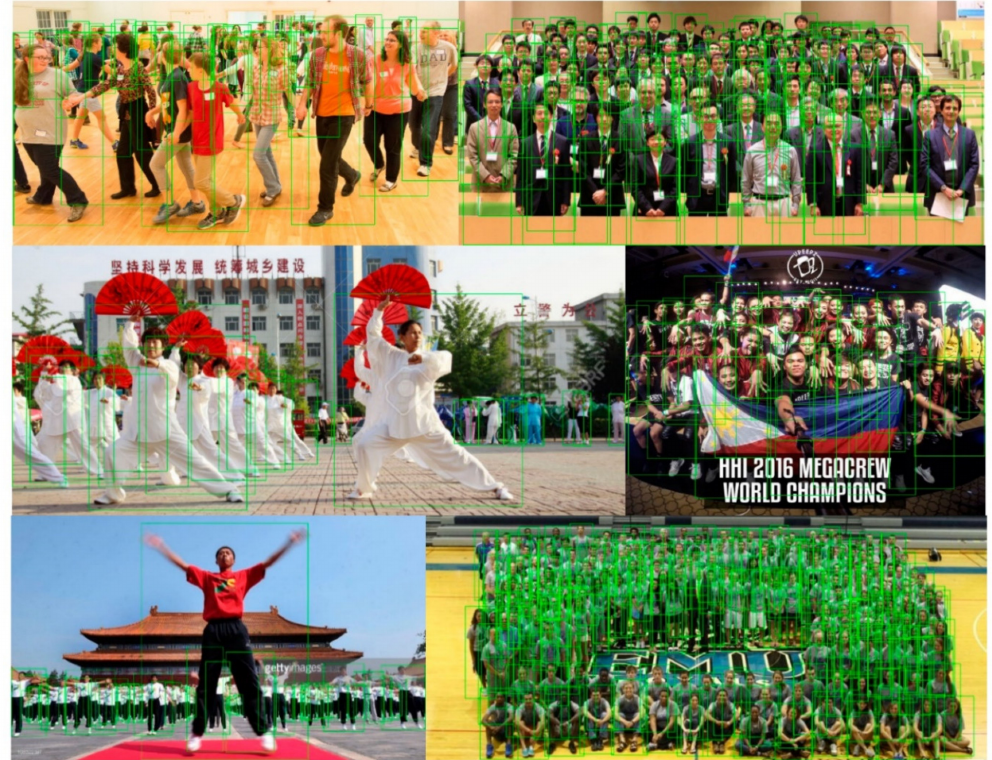
Figure 5. Detection results with our method. Although there are heavy occlusions in these images, the detector with our method can precisely detect the pedestrians.